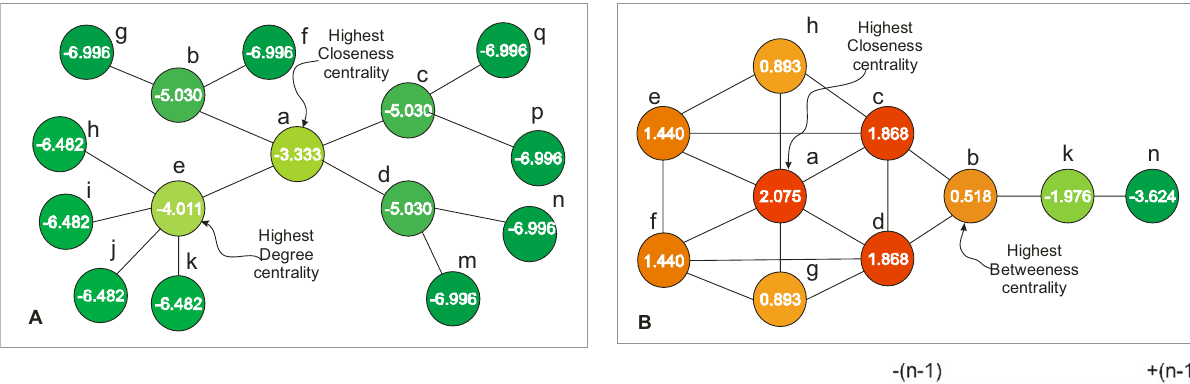
Figure 4. An illustrative example of the comparison between hierarchical closeness and other popular centralities for the prediction of total support. ( A ) Comparison with degree centrality. The highest closeness centrality outperforms the highest degree centrality in total support from the other nodes. ( B ) Comparison with betweenness centrality. The highest closeness centrality outperforms the highest betweenness centrality in total support from the remaining nodes. The color gradient represents the total support of a node ranging from −(n − 1) to + (n − 1), where n is the number of nodes. Note that hierarchical closeness and closeness exhibit the same ranking result in these two networks.